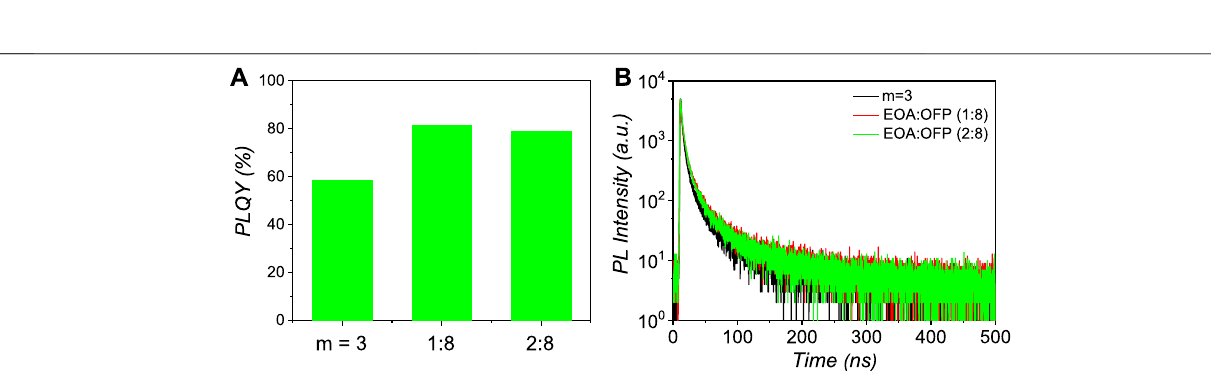
Frontiers in Chemistry |